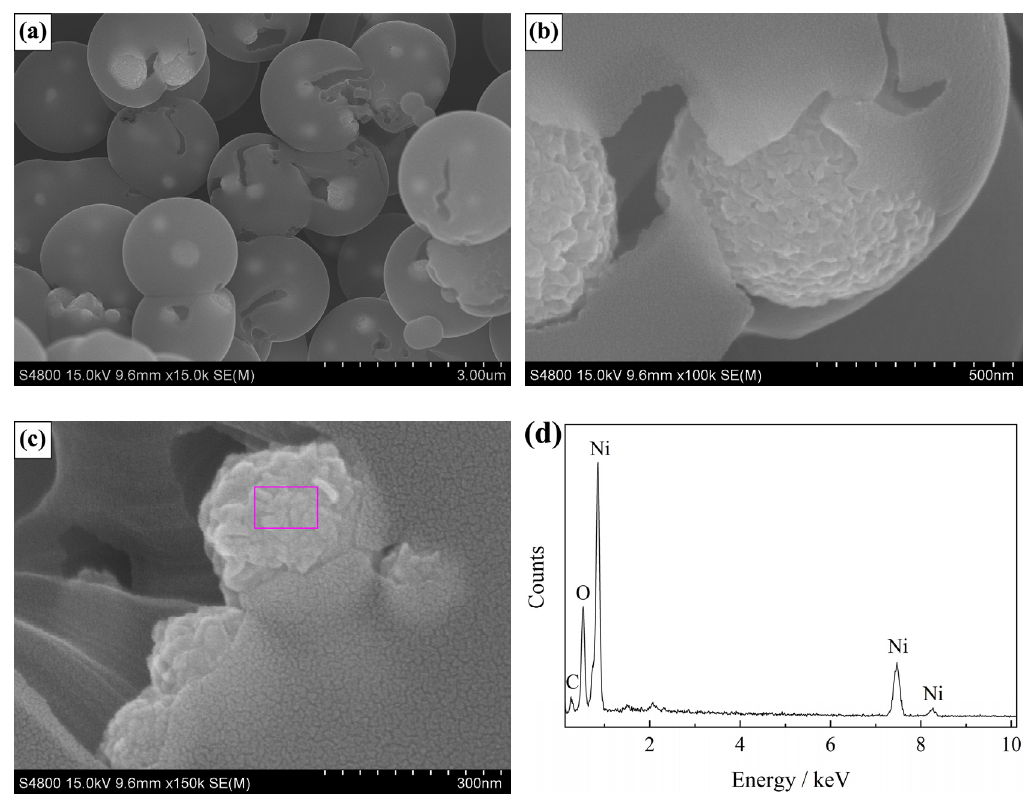
Figure 3. SEM characterization results of the NiO / C aerogel microspheres produced after the calcination in air: ( a ) low magnification image, ( b ) high magnification image, ( c ) cross-sectional image and ( d ) the corresponding EDS pattern.